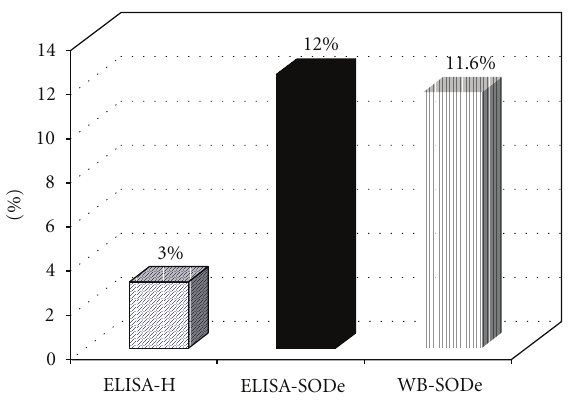
Figure 1: Seroprevalence of Chagas disease in suburban population of Quer´etaro city (Mexico) by ELISA (Homogenate and SODe) and Western Blot SODe tests.